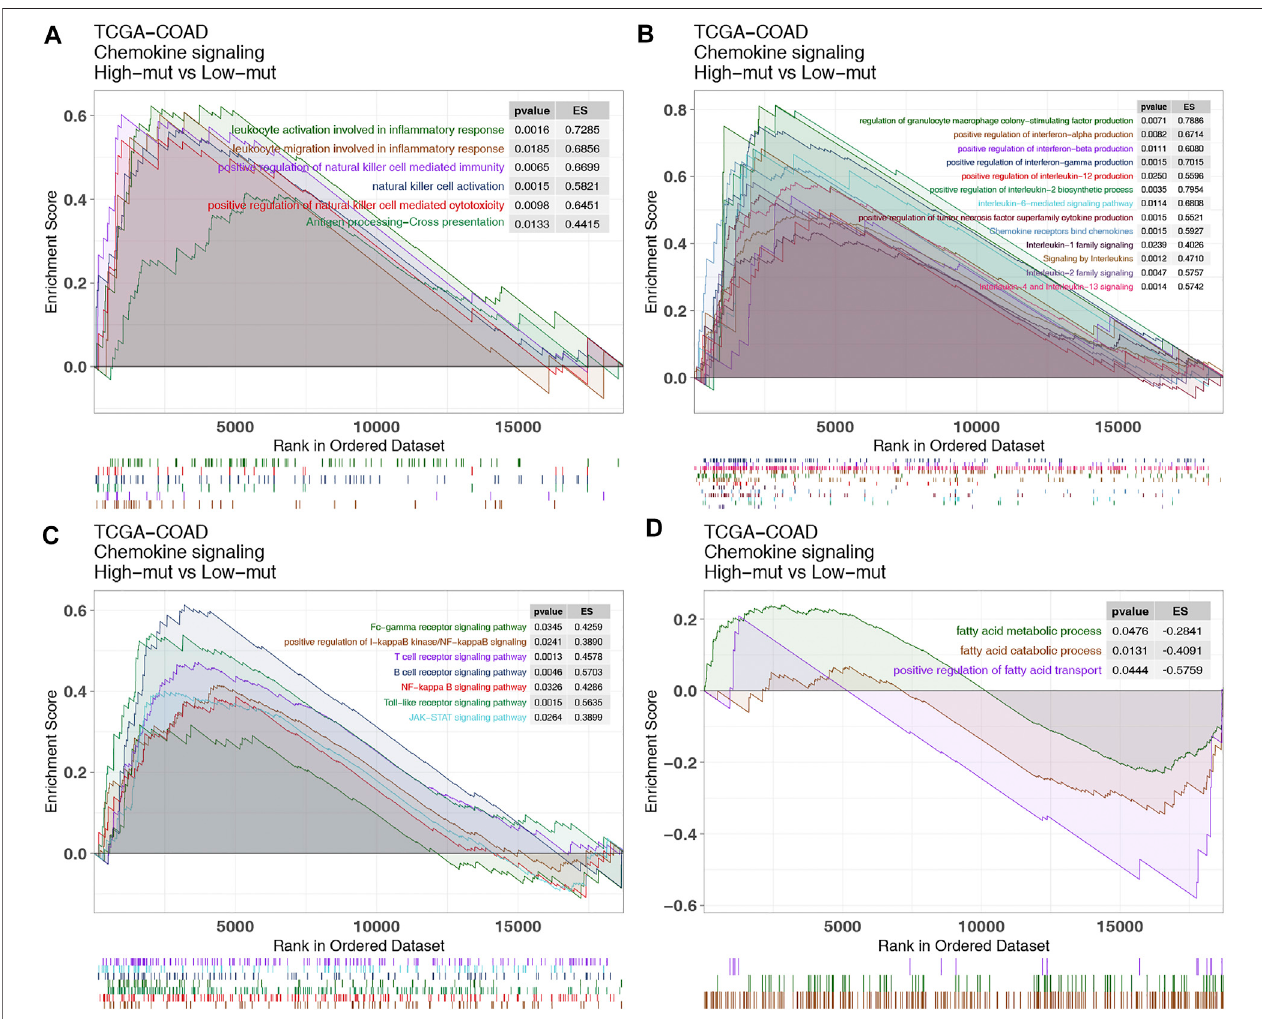
FIGURE 6 | Differentially enriched biological functions between high-mut and low-mut tumors in the TCGA-COAD cohort (identi fi ed by GSEA). Differences in immune cells (A) , cytokines (B) , classical immune related pathways (C) and exhaustion-related factors (D) between high-mut and low-mut tumors in the TCGA-COAD cohort (identi fi ed by